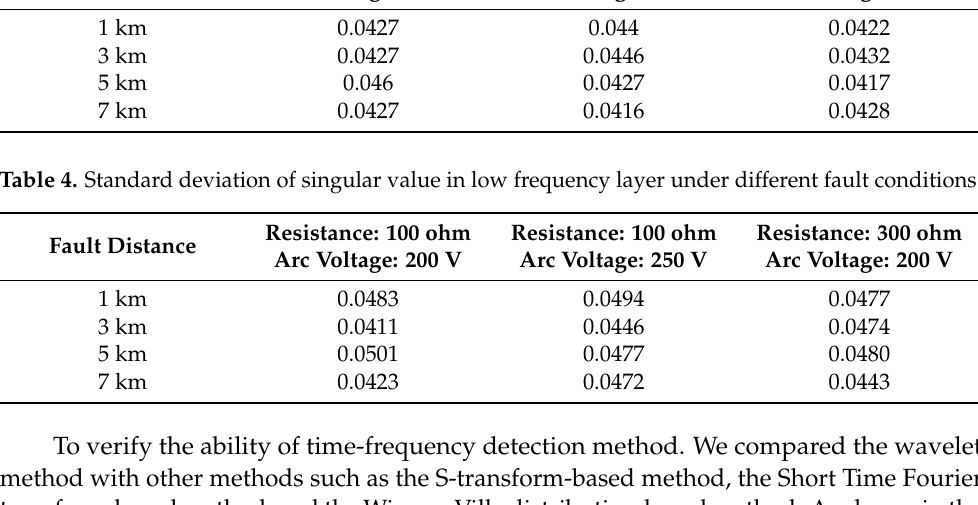
Table 4. Standard deviation of singular value in low frequency layer under different fault condi- tions.